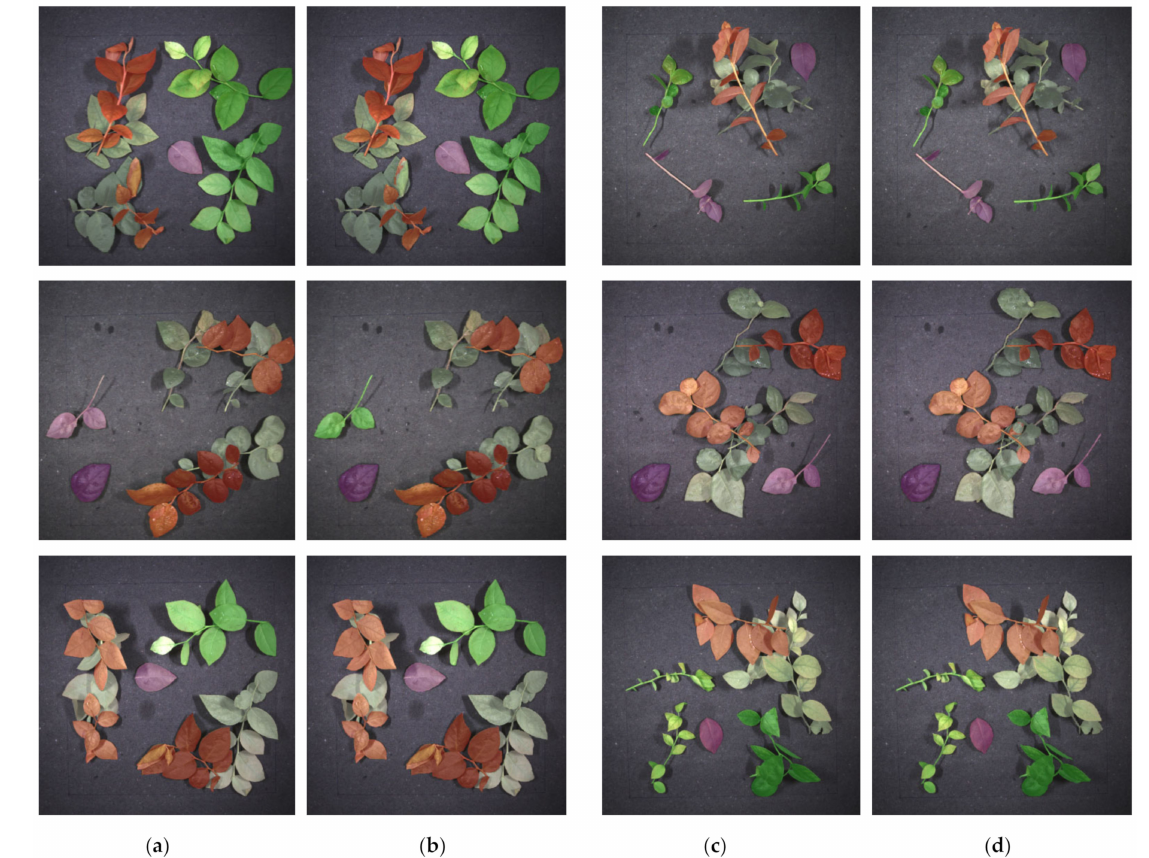
Figure 9. Examples of panoptic segmentation results with AdaptIS network on occluded plants dataset. ( a ) Ground truth of normal occlusion images. ( b ) Segmentation results of normal occlusion images. ( c ) Ground truth of complex occlusion images. ( d ) Segmentation results of complex occlusion images. In order to have a clearer visualization of cutting masks, the mask of the Stuff classes (here the image background) is not